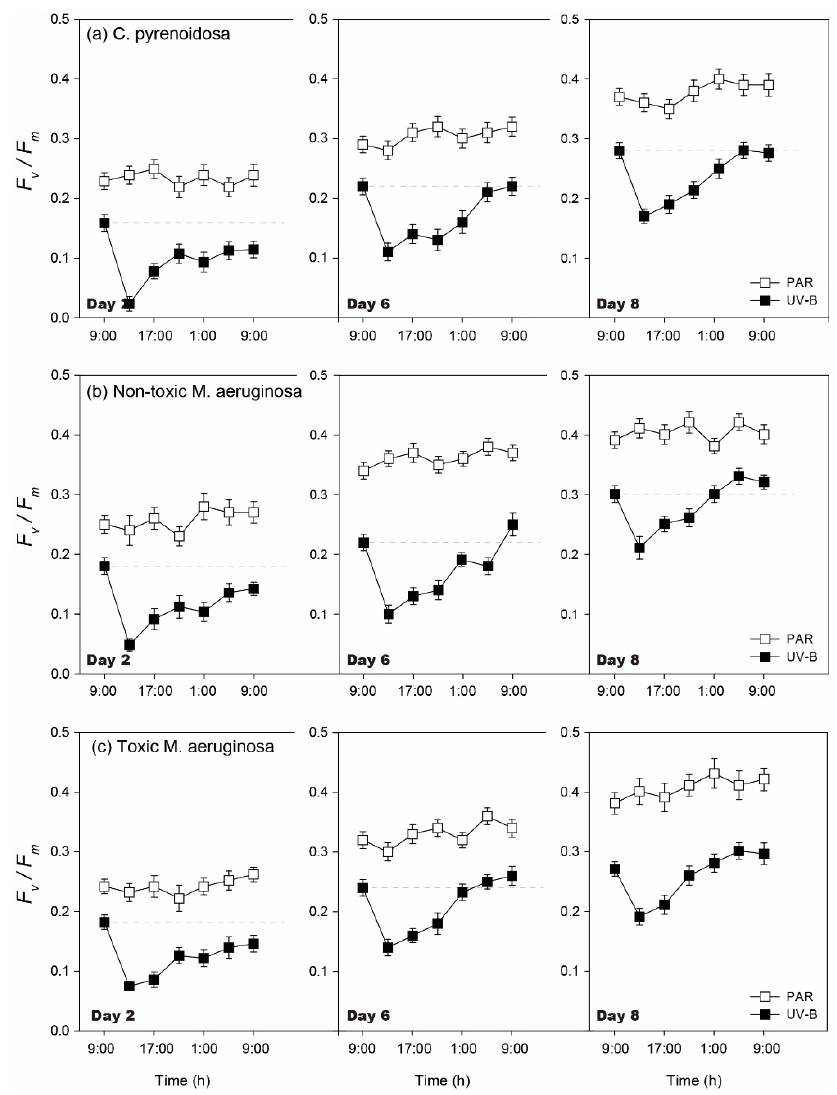
Figure 3. Diurnal changes of F v /F m of three species in the PAR and UV ‐ B treatments under normal growth conditions on Day 2, Day 6, and Day